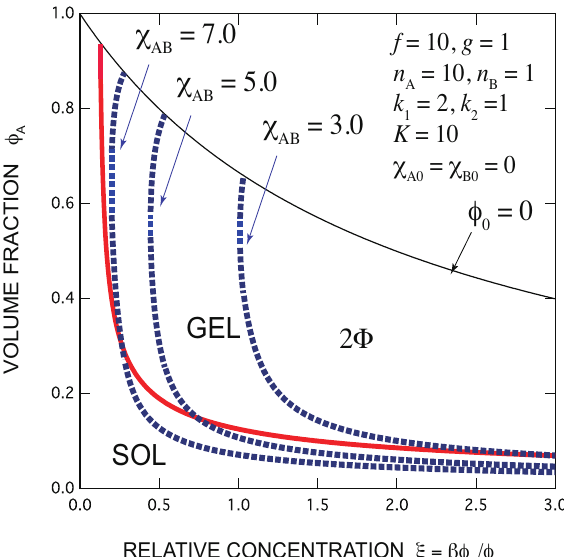
Figure 7. Phase diagram of monofunctional low molecular weight B molecules ( n B = 1, g = 1) with χ A , B varied (blue broken line) in a good solvent for f = n A = 10, ( k 1 , k 2 ) = ( 2,1 ) (sandwich cross-link of longer molecules). The lower bound of the gel region is ξ min = f (cid:48) k (cid:48) groups remain active on the surface of clusters under excess of B molecules. Clear gel region shrinks with increase in χ A , B , and eventually